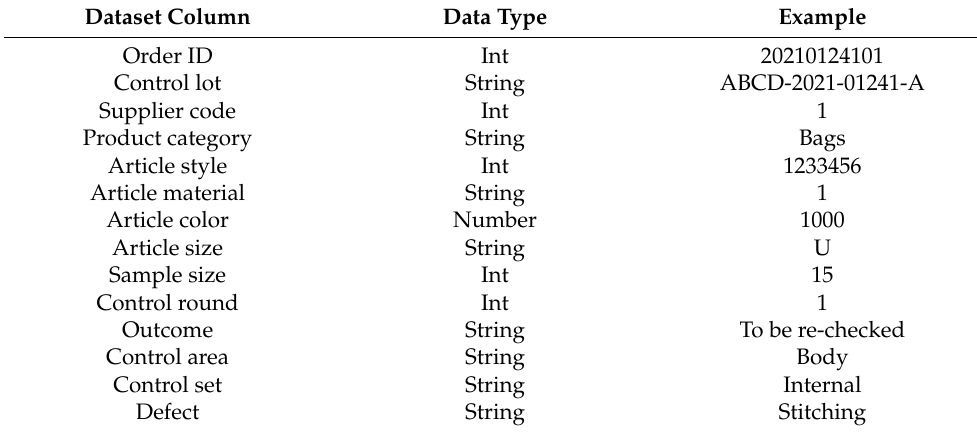
Table 2. Defect dataset structure.